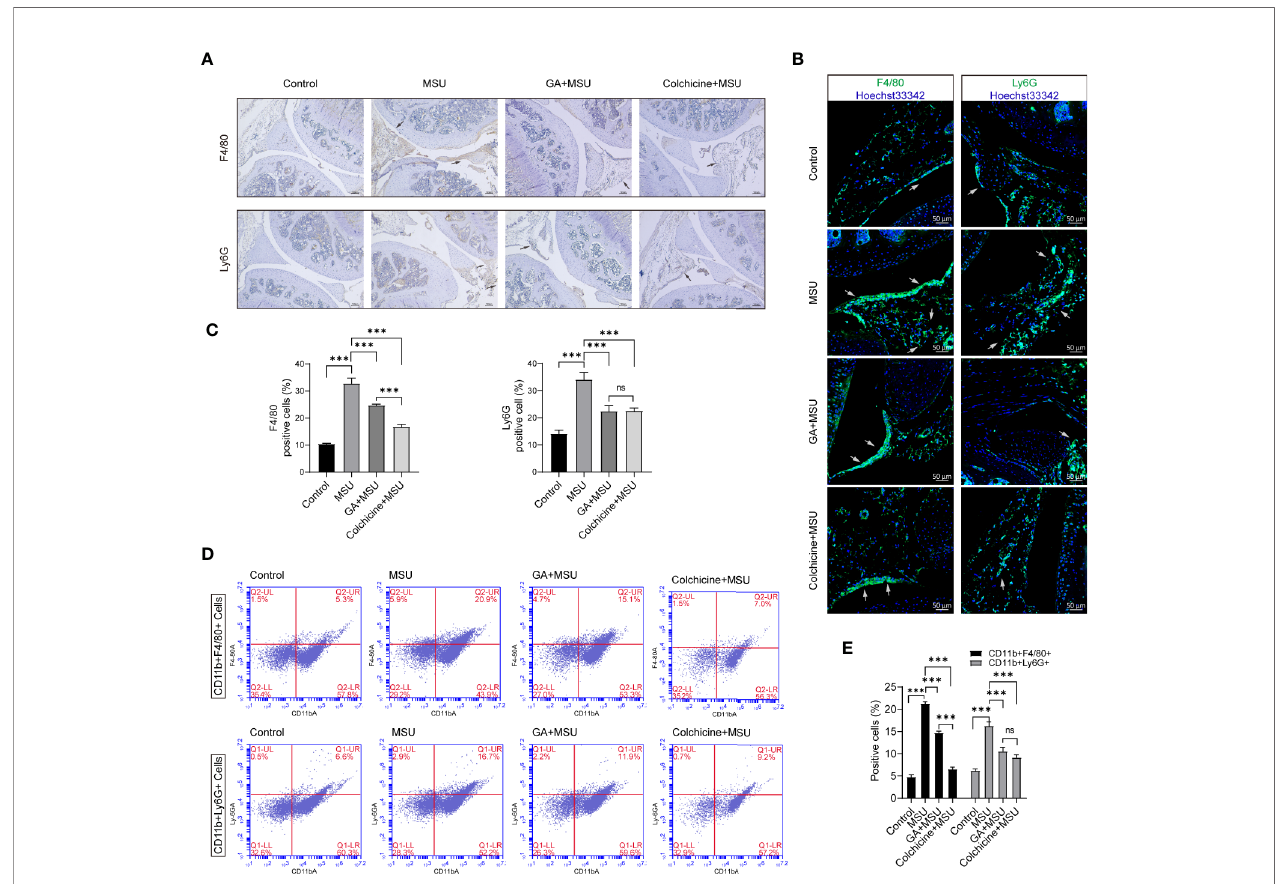
FIGURE 7 | Gallic acid reduces monosodium urate (MSU)-induced in fl ammatory cell in fi ltration in vivo . (A – D) C57BL/6J mice were treated with an intra-articular injection of MSU crystals (1 mg/mouse) with gallic acid (100 mg/kg) colchicine (1 mg/kg) for 24 h. (A) Representative immunohistochemistry images of F4/80 and/or Ly6G stained knee joint sections. Scale bars, 100 m m. (B) Representative immuno fl uorescence images of F4/80 and/or Ly6G stained knee joint sections. Scale bars, 50 m m. (C) The percentage of F4/80- or Ly6G -positive cells relative to total cells was calculated. Data are shown as means ± sem ( n = 6 mice). (D) The separate cells from the knee joint were stained with CD11b-FITC, F4/80-PE, and Ly6G-Percp-Cy5.5 to analyze macrophages and neutrophils subset by fl ow cytometry. (E) The percentage of CD11b+F4/80+ and CD11b+Ly6G+ cells relative to total cells was calculated. Data are shown as means ± sem ( n = 6 mice). GA, gallic acid. * P < 0.05, ** P < 0.01, *** P < 0.001. ns, not signi fi